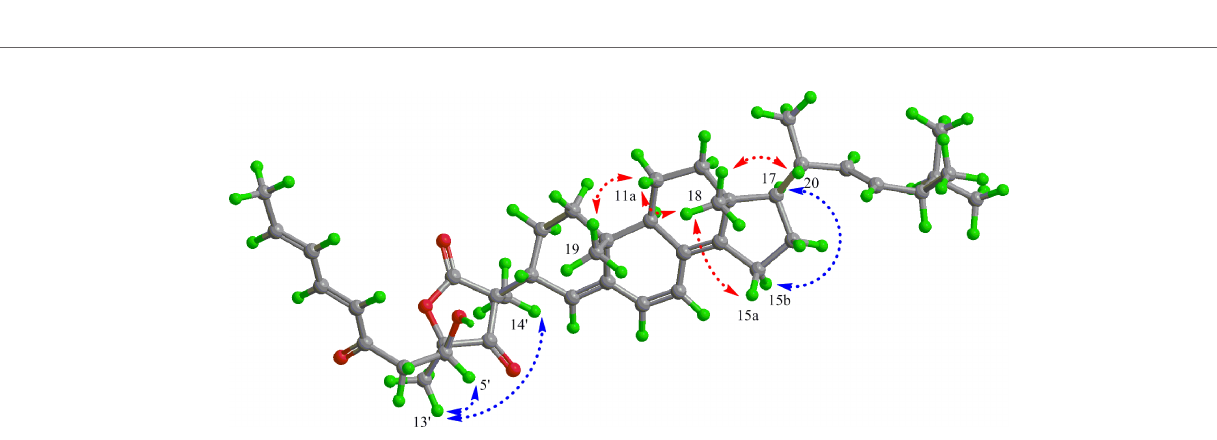
FIGURE 3 | NOESY correlations of 1